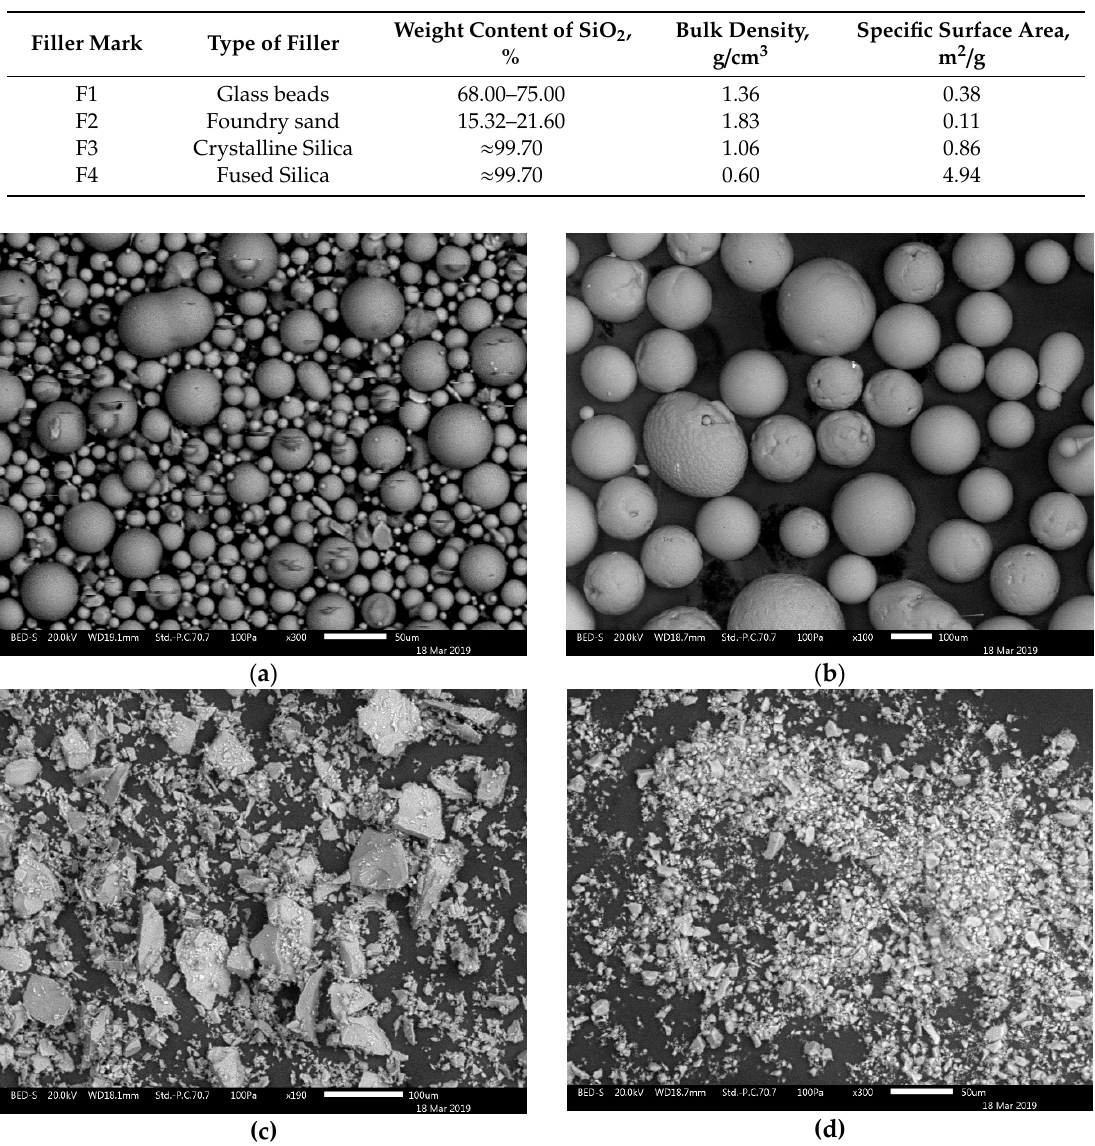
Table 1. Weight content of silicon dioxide, bulk density and specific surface area of the tested fillers.